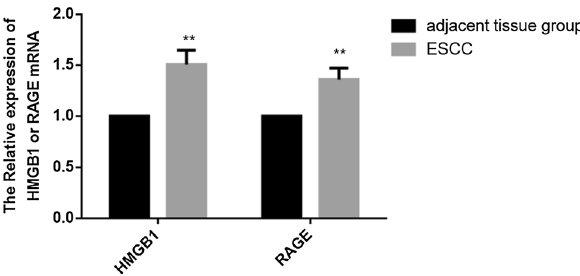
Fig. 2 qRT–PCR: The mRNA expression patterns of HMGB1 and RAGE in the tumor esophageal tissue (ESCC) and adjacent esophageal tis- sue. The mRNA expression of HMGB1 and RAGE were markedly increased in the ESCC group than the control group. Data was presented in mean ± SD, **P <